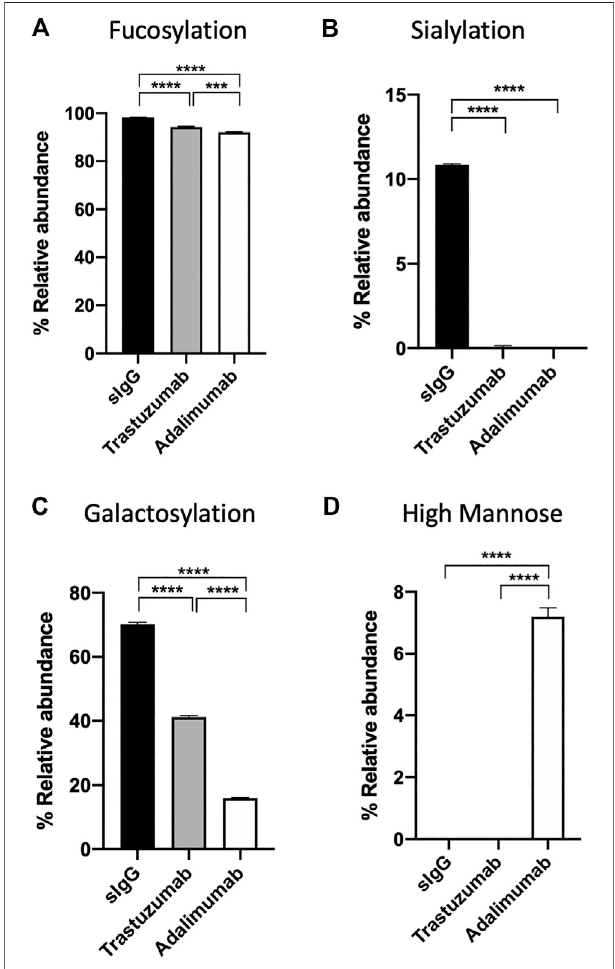
FIGURE 5 | The relative abundance of (A) fucosylation, (B) sialylation, (C) galactosylation, and (D) high mannose structure of serum IgG, trastuzumab, and adalimumab. (One-way ANOVA followed by Bonferroni ’ s post hoc test, multiple comparisons were performed between serum IgG, transtuzumab, and adalimumab, n (cid:2) 4; *** p < 0.001; **** p < 0.0001).